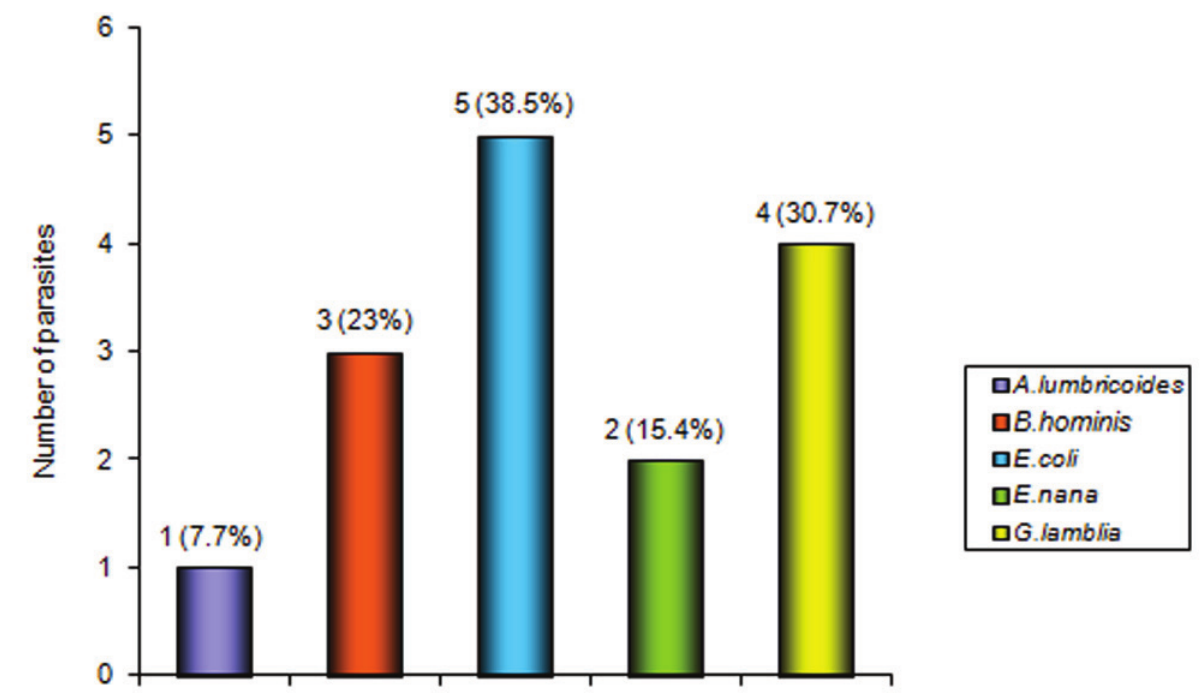
Figure 1. Number of intestinal parasites in HIV/AIDS individuals treated at the Specialized Outpatient Service and Day Hospital Professor Emeritus Domingos Alves Meira, UNESP, 2007-2008. The p value obtained by adjusted negative binomial model was <